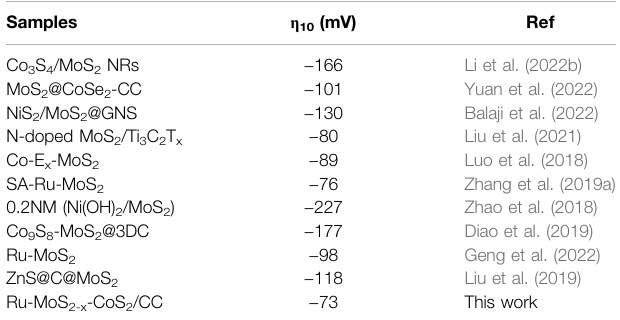
TABLE 1 | Comparison of the HER electrocatalytic activity of Ru-MoS 2-x -CoS 2 / CC with some MoS 2 -based HER electrocatalysts recently reported.